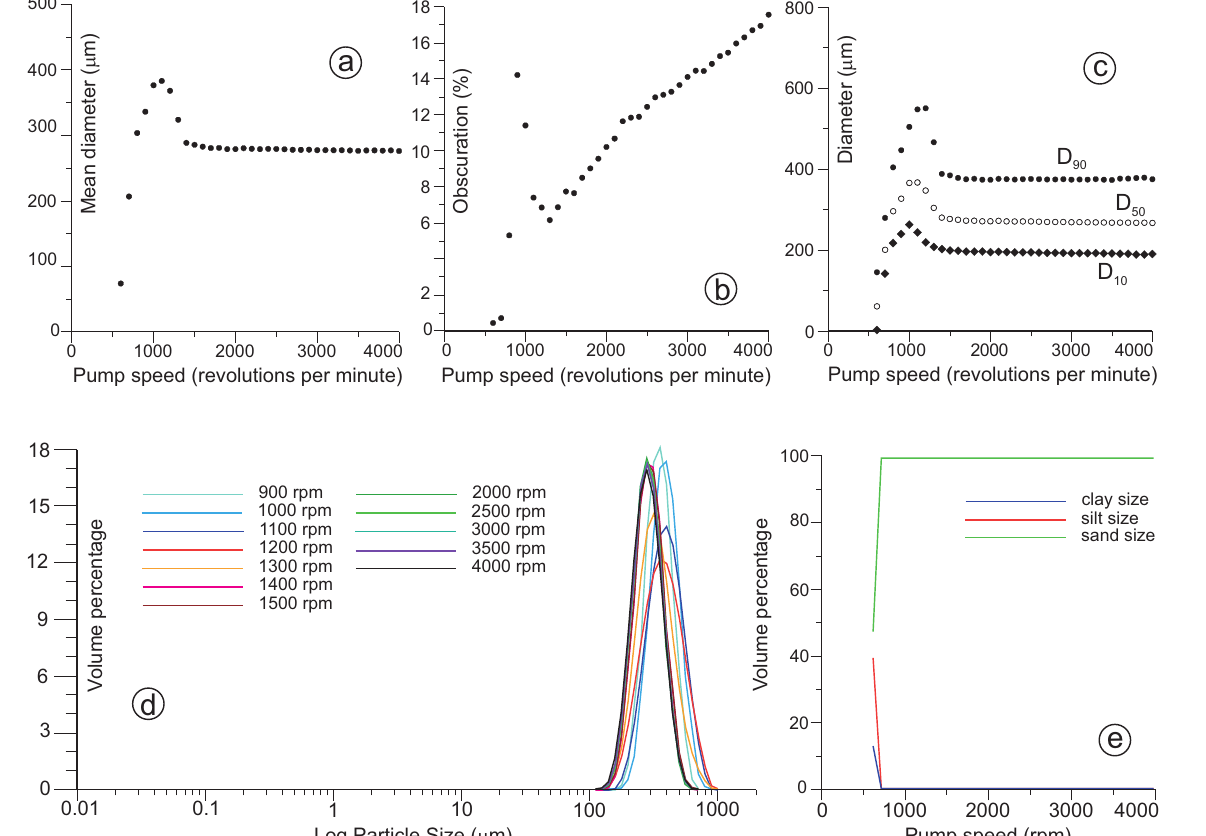
Fig. 3. Results of the pump speed test P 5 performed on sub-sample aliquot SAND1a by the Hydro 2000 MU dispersion unit. (a) Mean diameter value evolution with increasing the pump speed from 600 up to 4000rpm. (b) Laser obscuration value progression during the same test. (c) Progression of D 10 , D 50 , and D 90 during the same test. (d) Granulometric curves obtained by averaging data from the corresponding 10 measurement runs during representative pump speed steps. (e) Distribution of clay, silt, and sand size fractions during the test. Note that the sand fraction quickly reaches 100% of the sample material. See text for